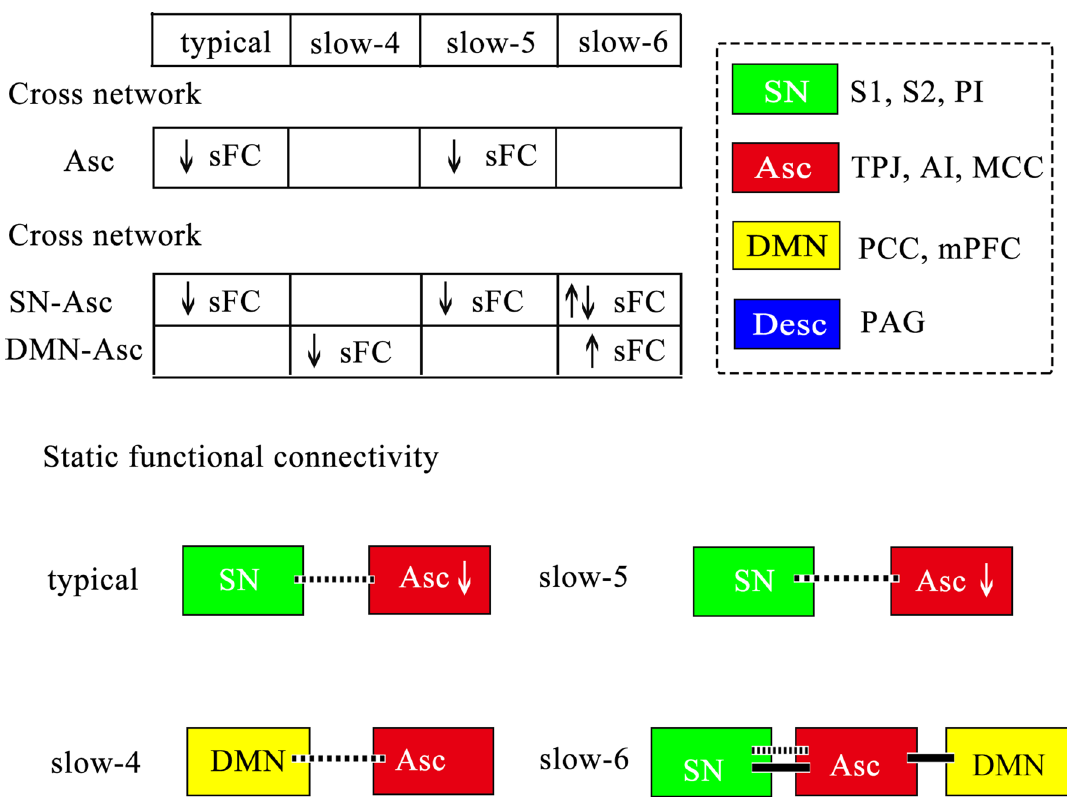
Figure 1. Summary figure showing within- and cross-network sFC and dFC variability abnormalities in chronic low back-related leg pain. Two-sample t test, P < 0.05, FDR correction. Note: The within- and cross- network abnormalities in the typical and five specific frequency bands are shown as a table in the figure. The right panel shows the legend for the dynamic pain connectome. Green indicates the salience network, blue indicates the descending antinociceptive pathway, and red indicates the ascending nociceptive pathway. Both static and dynamic functional connectivity variability are depicted in the figure. Solid lines indicate hyperconnectivity, and dotted lines indicate hypoconnectivity between networks. sFC static functional connectivity, DMN default mode network, SN salience network, Asc ascending nociceptive